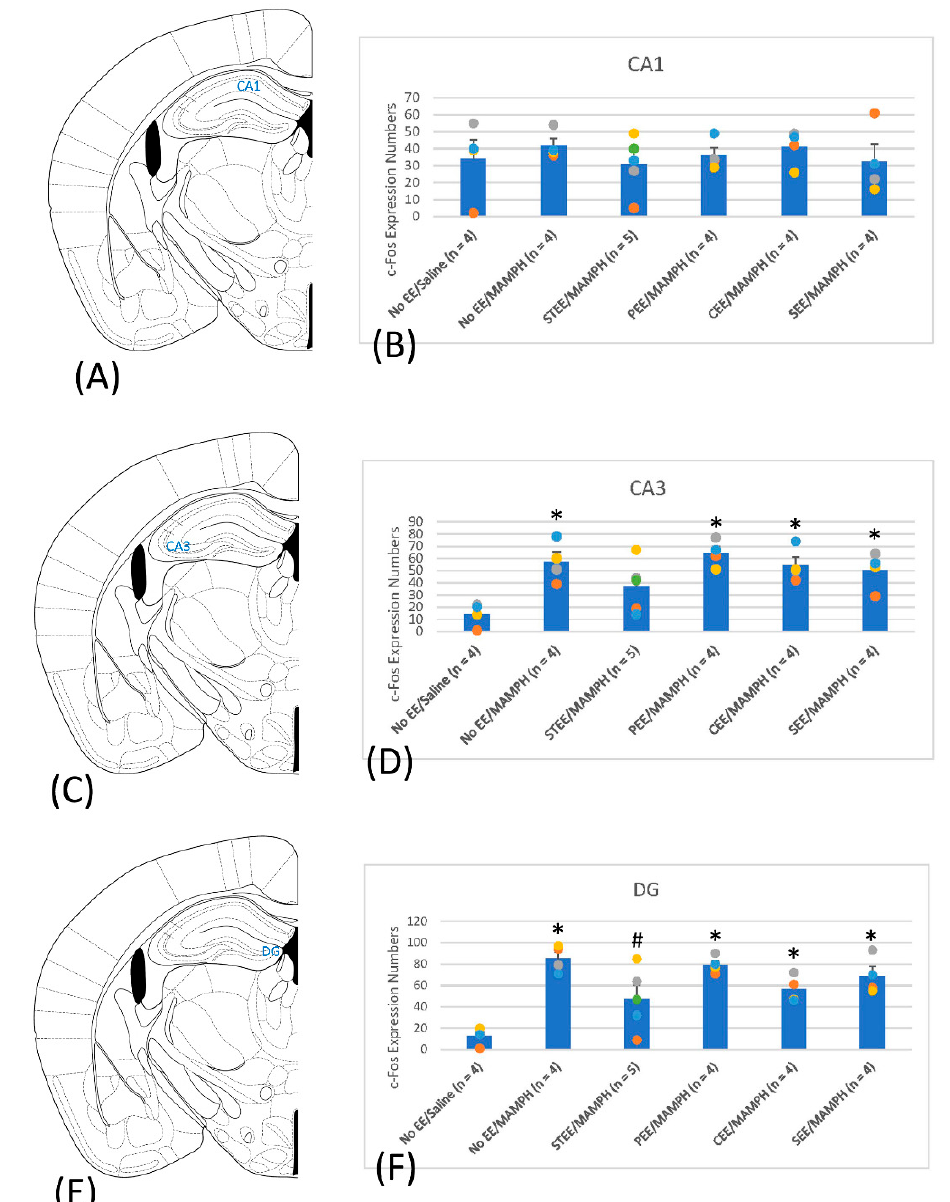
Figure 4. A cartoon brain atlas showing the ( A ) CA1, ( C ) CA3, and ( E ) dentate gyrus (DG) of the hippocampus and c-Fos expression in ( B ) the CA1, ( D ) CA3, and ( F ) DG for the No environ- mental enrichment (EE)/Saline ( n = 4), No EE/methamphetamine (MAMPH; n = 4), standard EE (STEE)/MAMPH ( n = 5), physical EE (PEE)/MAMPH ( n = 4), cognitive EE (CEE)/MAMPH ( n = 4), and social EE (SEE)/MAMPH ( n = 4) groups; * p < 0.05 compared with the No EE/Saline group, and # p < 0.05 compared with the No EE/MAMPH